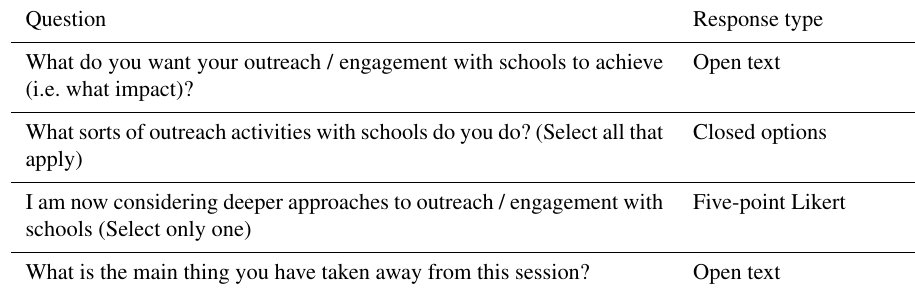
Table C1. The questions asked of university researchers and engagement